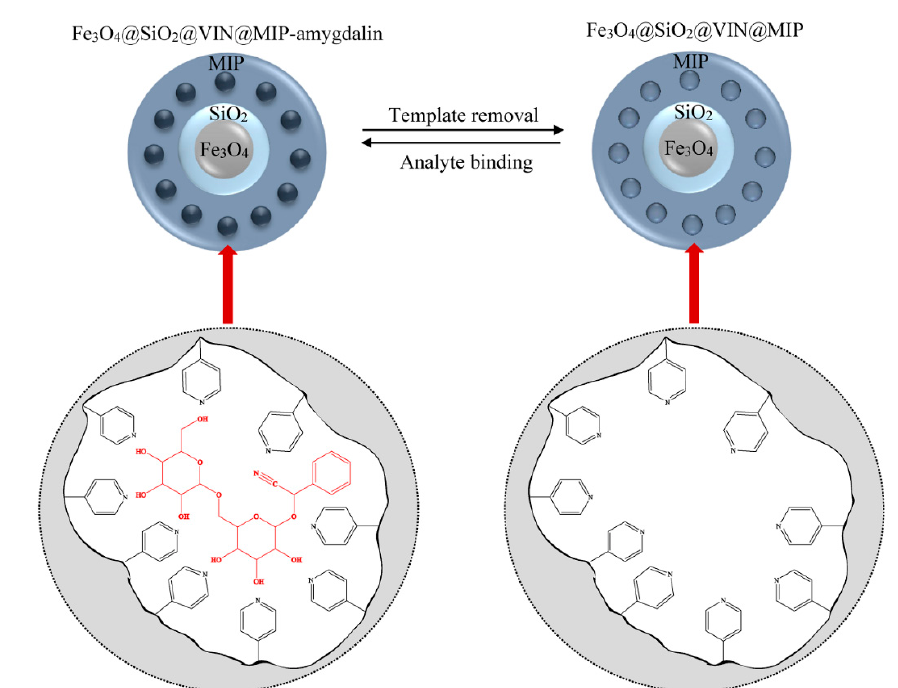
Figure 14. Scheme of Fe 3 O 4 @SiO 2 @VIN@MIP synthesis.